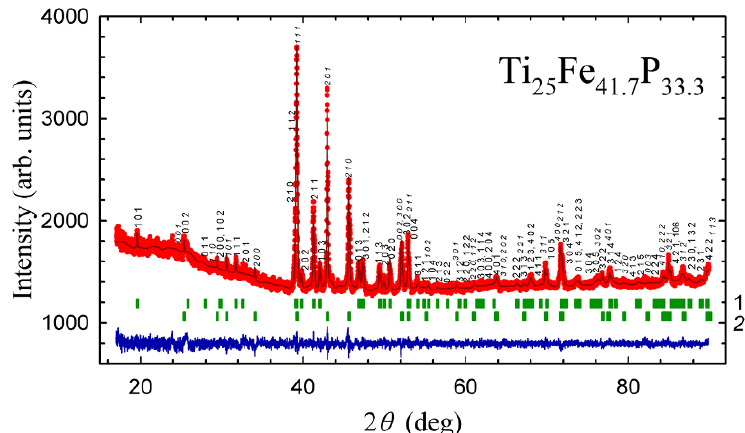
Figure 6. Observed ( ۰ ) calculated (-) and difference X-ray diffraction patterns of the Ti